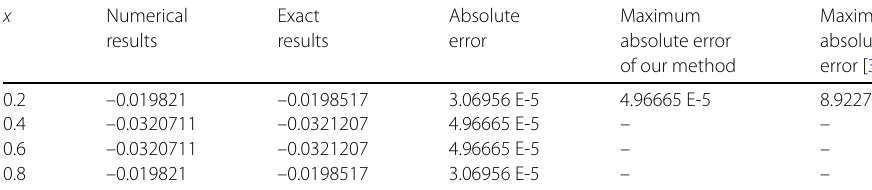
Table 7 The numerical results for the fifth test problem at y = z = 0.5, x , y , z ∈ [0,1] x Numerical